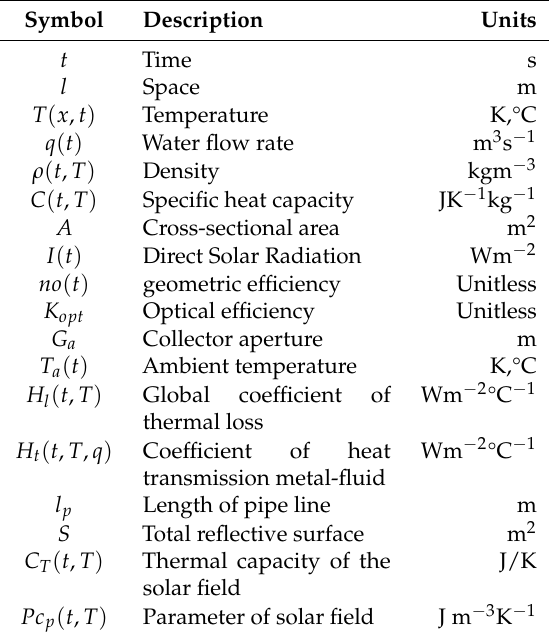
Table 1. Parameters